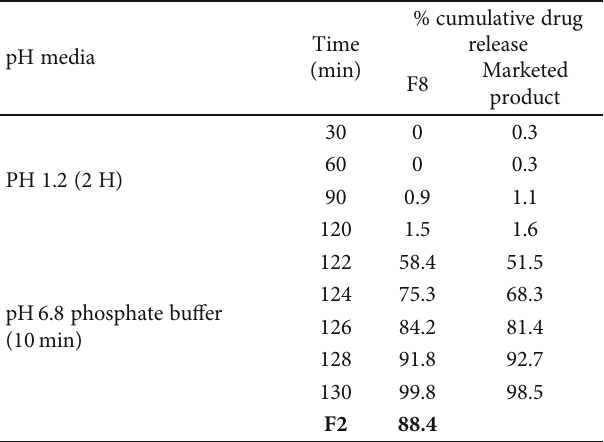
Table 6: Comparative dissolution pro fi le of F8 with marketed